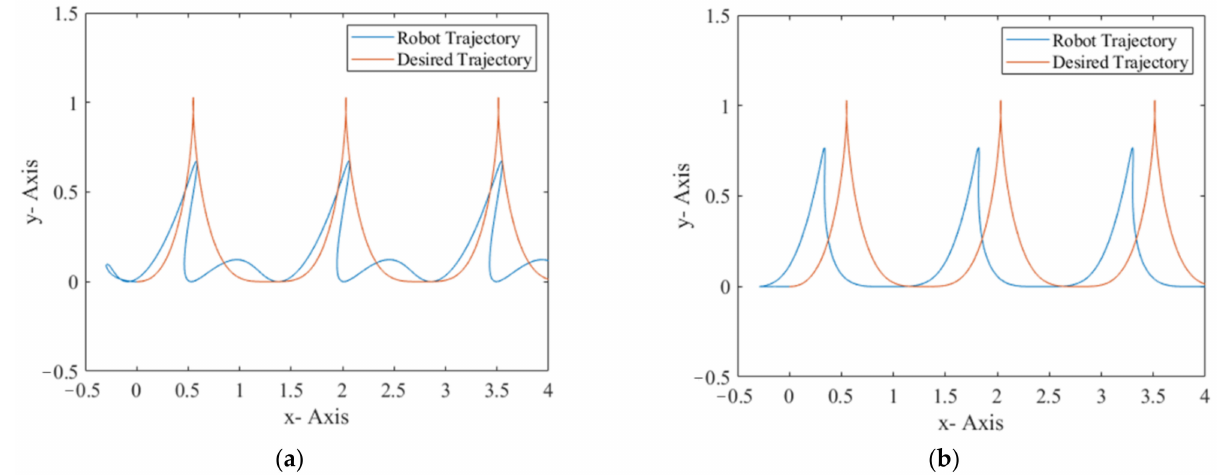
Figure 13. Comparison of ( a ) best simulation with the IT3FC and ( b ) worst simulation with the IT3FC proposed method with URN